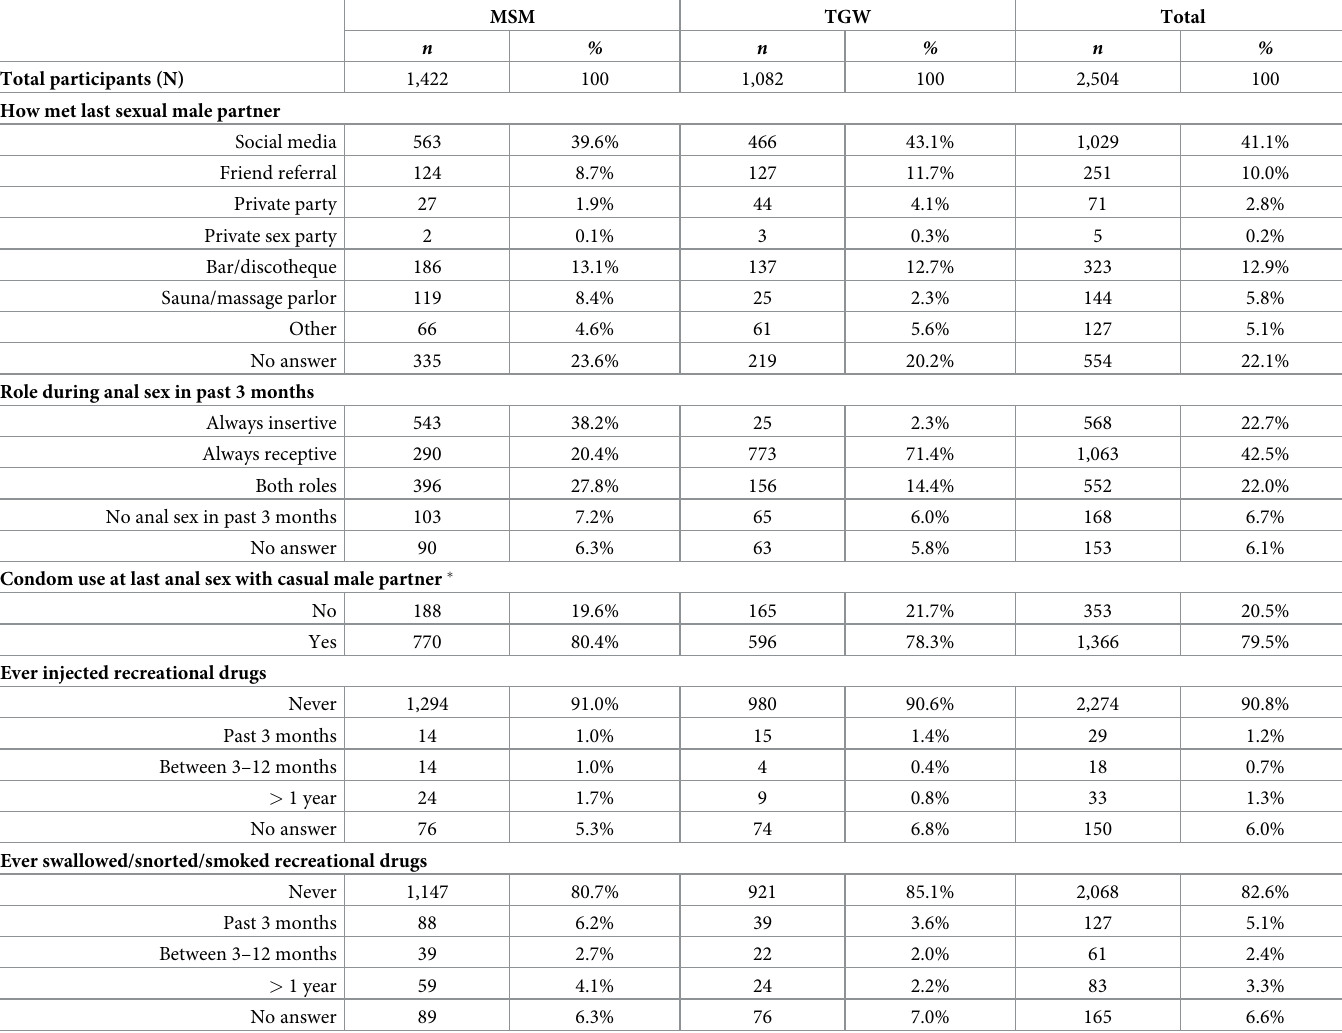
Table 2. Key behavioral characteristics of